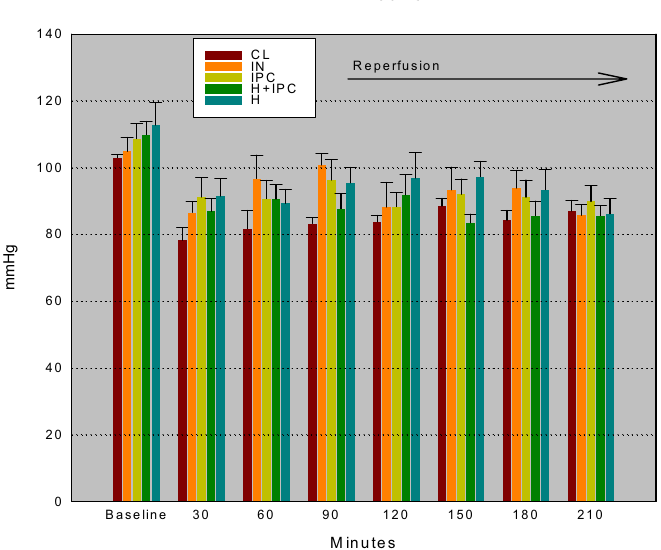
Tem perature Means